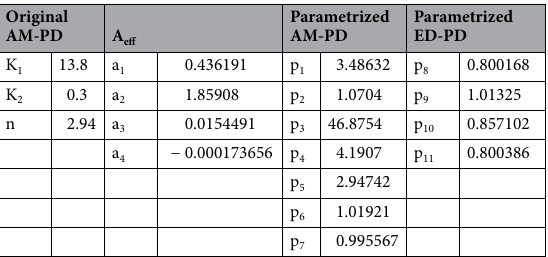
Table 1. Model parameters for original and parametrized